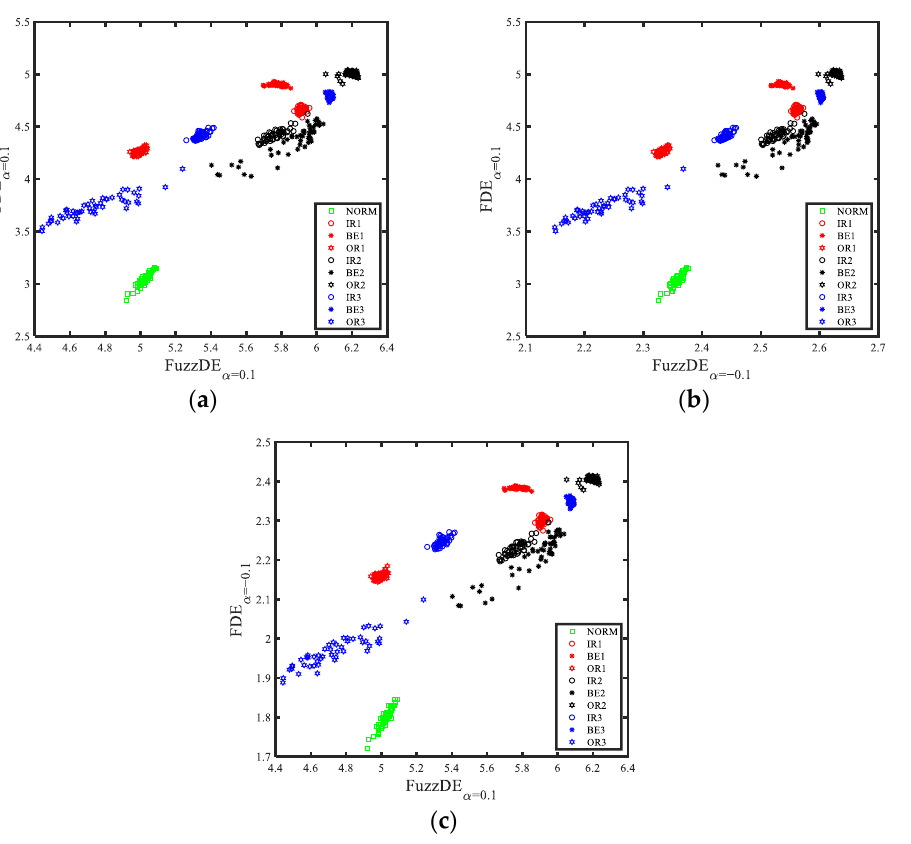
Figure 11. Distribution of the highest classification recognition rate of mixed double features. ( a ) FuzzDE α = 0.1 & FDE α = 0.1 ; ( b ) FuzzDE α = −0.1 & FDE α = 0.1 ; ( c ) FuzzDE α = 0.1 & FDE α = −0.1 .